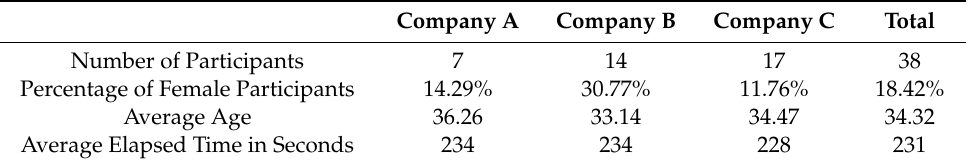
Table 4. Statistics About the Experiment.